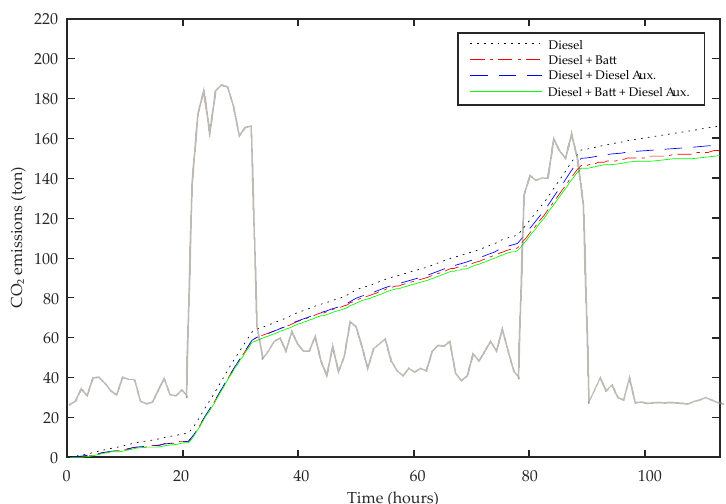
Figure 14. Accumulated CO 2 emissions for the four cases simulated in contrast to the demand curve. The most inclined segments represent the mission parts that have the highest CO 2 emissions, while the difference between the curves at the beginning and at the end of the mission part shows the periods that have the highest reduction of CO 2 emissions. The round trip efficiency of the battery is kept at 92%. In the case that includes only the diesel generators, the minimum load level of the generators is 10% for one diesel generator and 50% for the other three diesel generators when the ship is in loading in port and standby and 50% for all diesel generators when the ship is in laden voyage, DP operation, and partial load voyage. In the case that includes diesel generators and batteries, the minimum load level is 50% for all generators. The case considering diesel generators and auxiliary diesel generators has a minimum load level fixed at 50% for all generators. In the case that considers the diesel generators, batteries, and the auxiliary diesel generators, the minimum load level is also 50%.